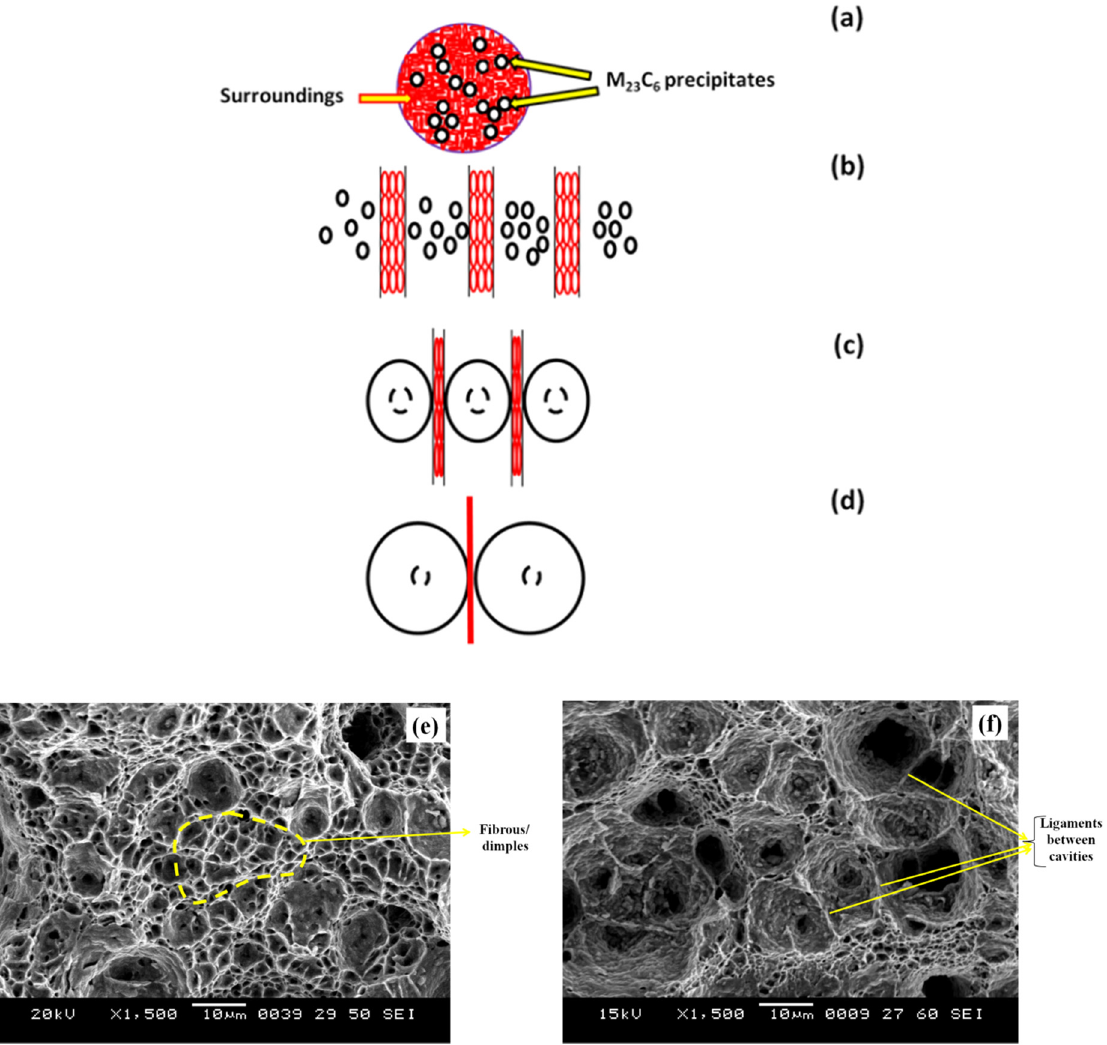
Figure 10: ( a – d ) Proposed mechanism for precipitate coarsening and fracture. SEM fractographs obtained for ruptured specimens of 1060°C/740°C at ( e ) 325 MPa/199 h and ( f ) 235 MPa/4,321